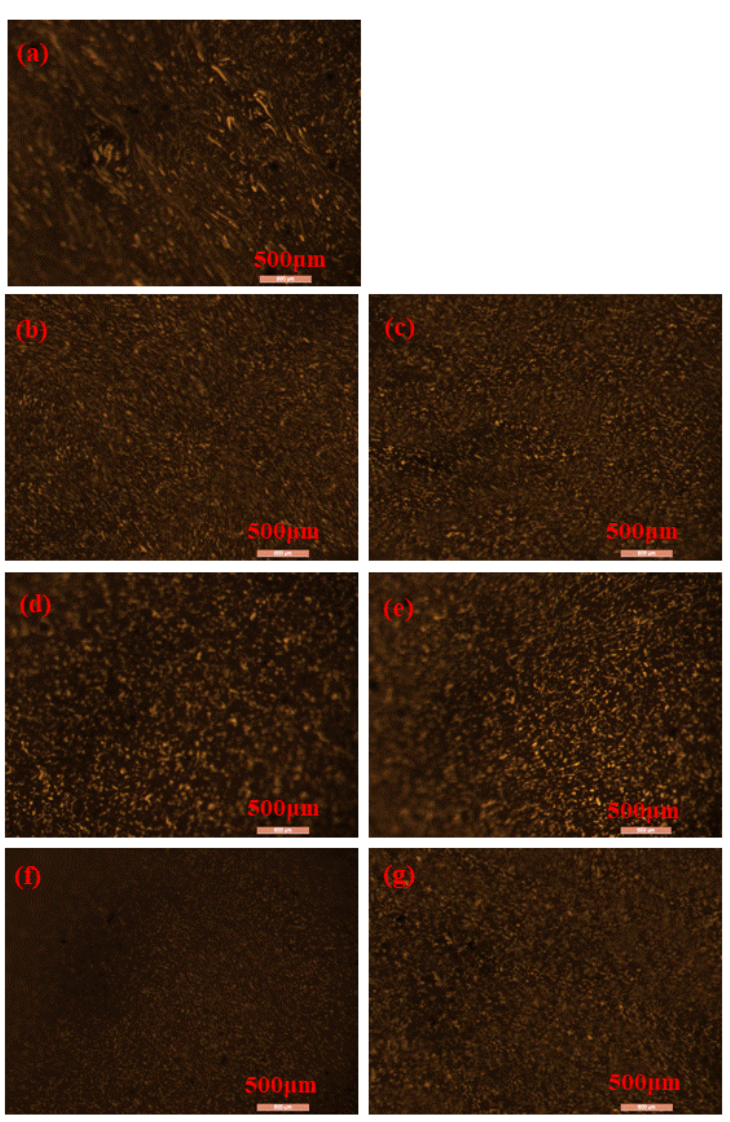
Figure 13. Fluorescence electron microscopy of composite-modified asphalt with different dosages. ( a ) 4% SBS, ( b ) 7.5% RHB + 4% SBS, ( c ) 10% RHB + 4% SBS, ( d ) 12.5% RHB + 4% SBS, ( e ) 15% RHB + 4% SBS, ( f ) 15% RHB + 2% SBS, ( g ) 15% RHB + 3% SBS.